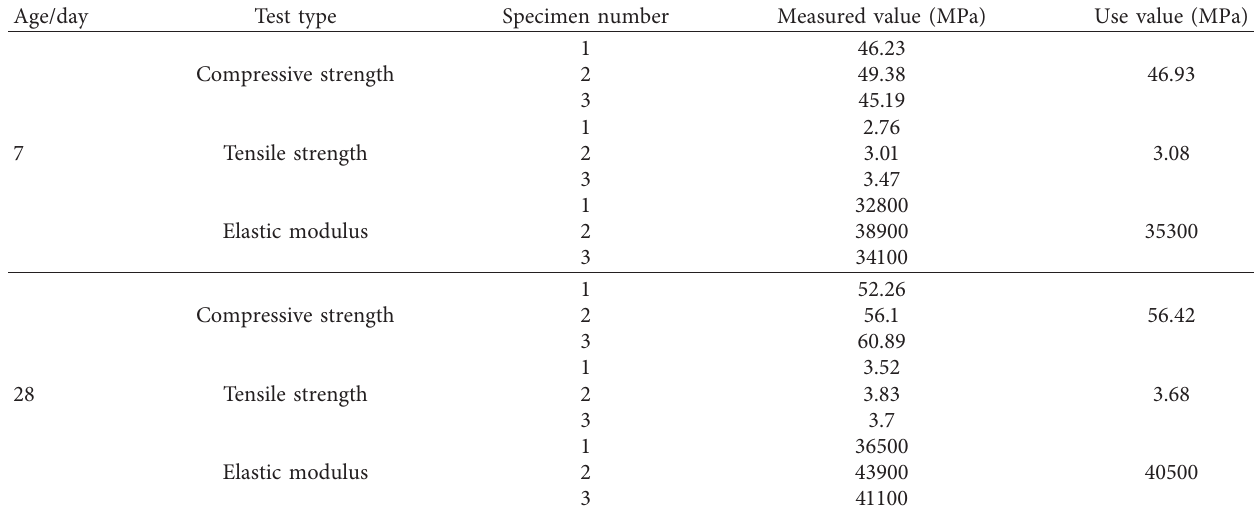
Table 2: Basic mechanical properties of concrete at 7 days and 28 days.